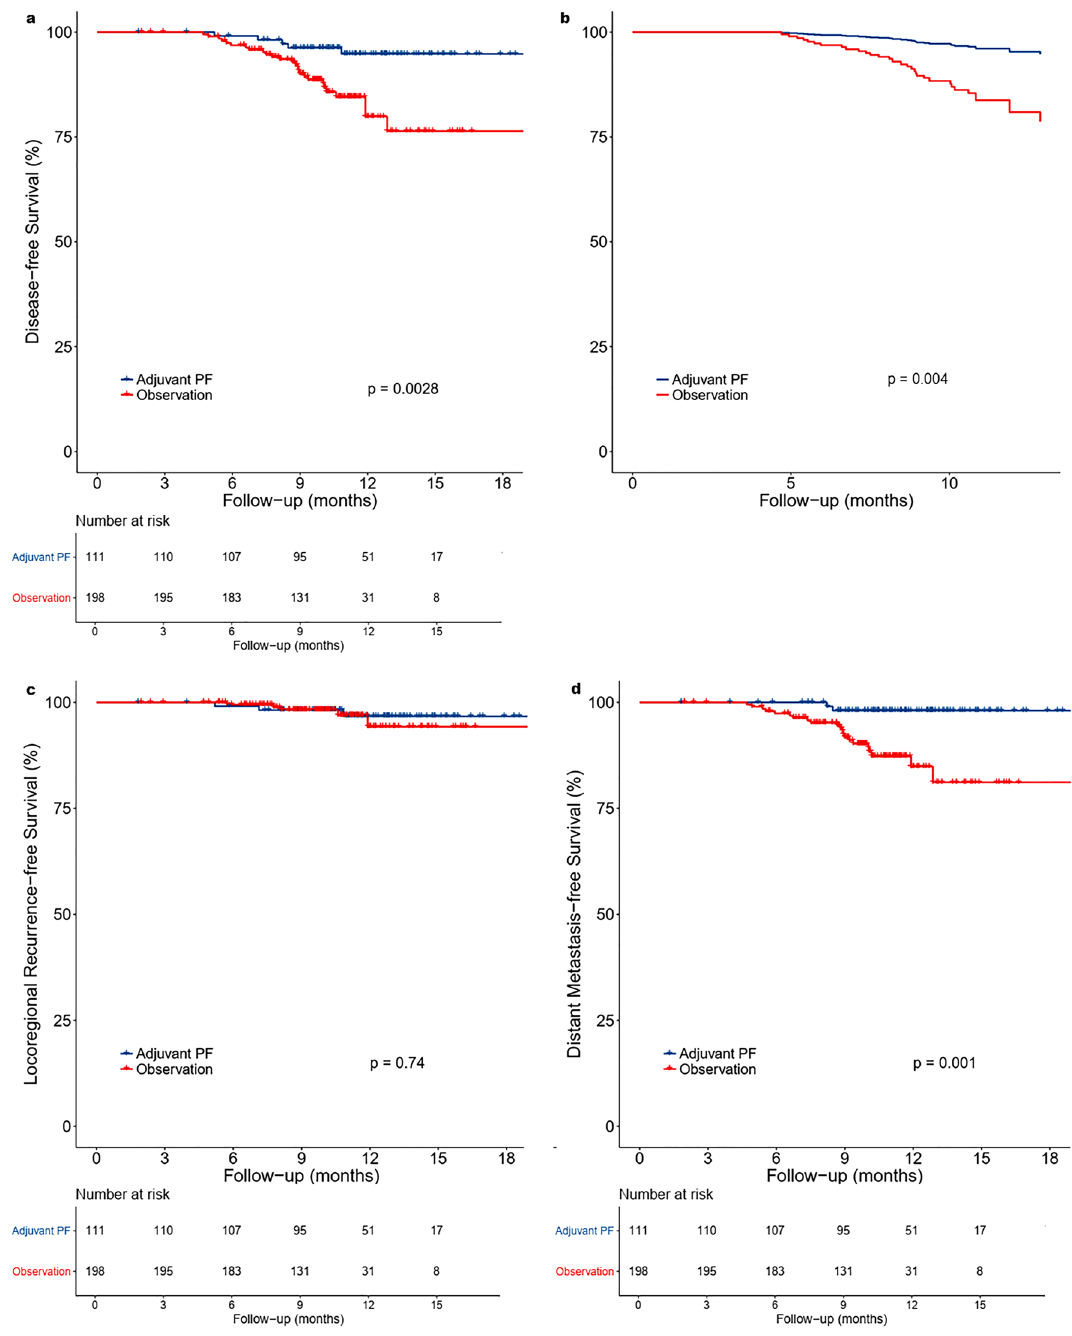
Figure 2. Kaplan–Meier survival curves ( a ) and multivariate adjusted survival curves ( b ) for disease-free survival show a higher percentage of patients being disease-free in the adjuvant PF chemotherapy group; meanwhile, Kaplan–Meier survival curves show ( c ) similar locoregional control and ( d ) higher rates of freedom from distant metastasis in the adjuvant PF chemotherapy group. Figure created with R version 3.6.0 (https:// www.r- proje ct.